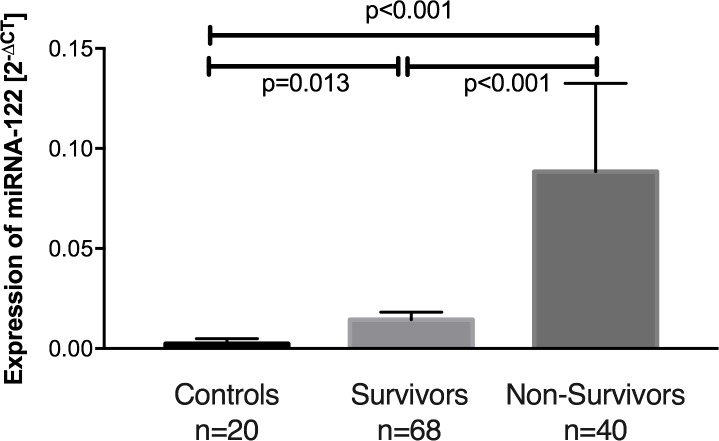
Relative miR-122 expression in control patients, sepsis survivors, and sepsis non-survivors.Means with standard error of the mean.